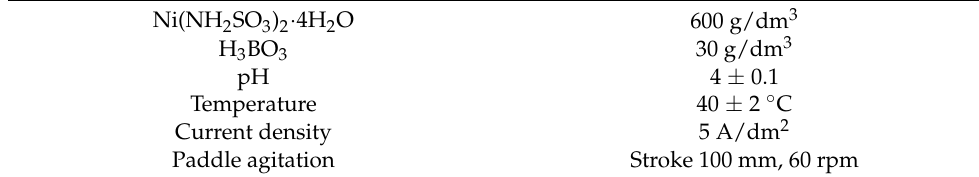
Table 1. Bath composition for Ni electroforming.